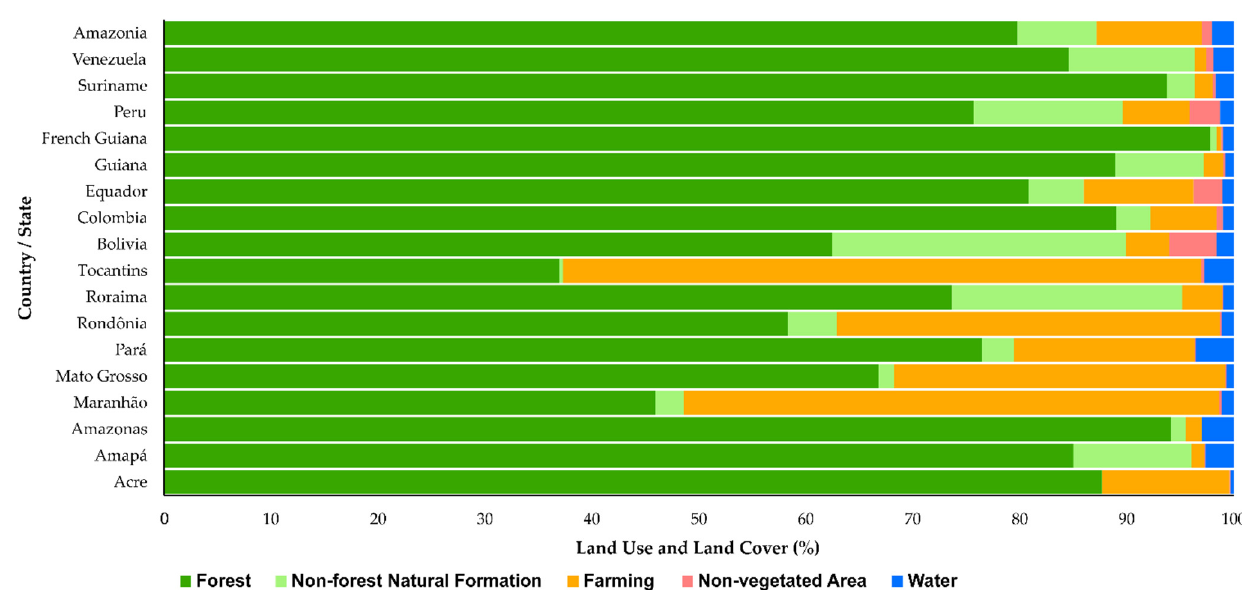
Figure 6. Spatial distribution of Land Use and Land Cover categorized by the MapBiomas Amazo- nia dataset Collection 2.0 in Amazonia for the year 2018. BO = Bolivia, CO = Colombia, EC = Ecuador, FG = French Guiana, GU = Guiana, PE = Peru, SU = Suriname, VE = Venezuela, AC = Acre, AM = Amazonas, AP = Amapá, MA = Maranhão, MT = Mato Grosso, RO = Rondônia, RR = Roraima, PA = Pará and TO = Tocantins.